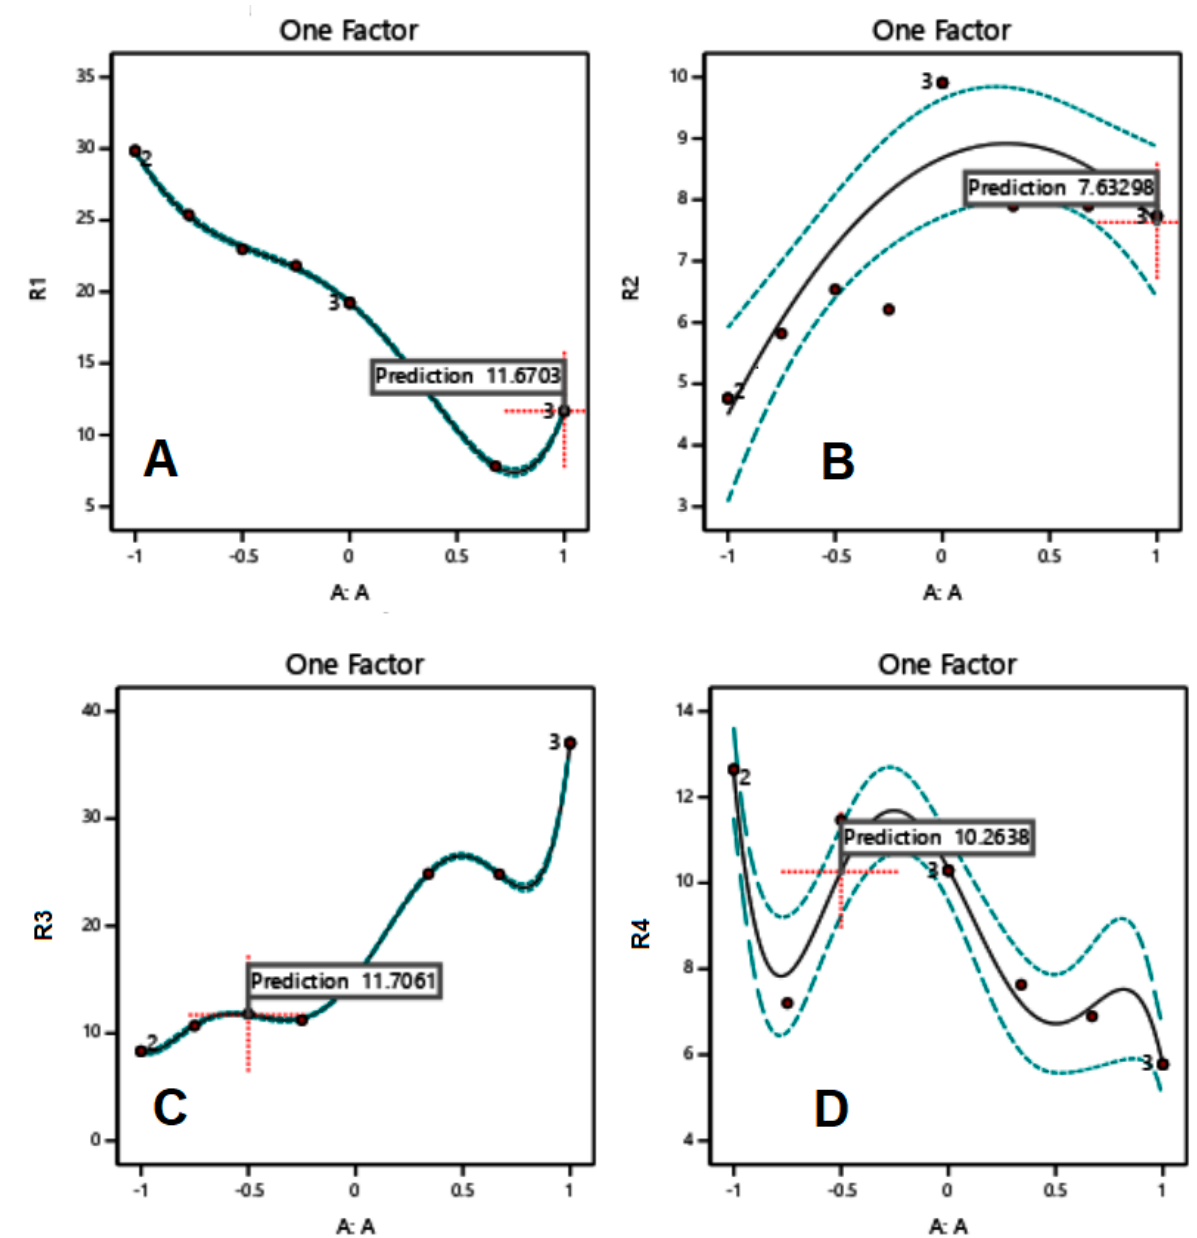
Figure 3. RSM of MCC-Mg silicate for a one-factor design with yield pressure ( P Y ) ( A ), P K ( B ), work of compression ( C ), and tablet hardness ( D ) as the responses.